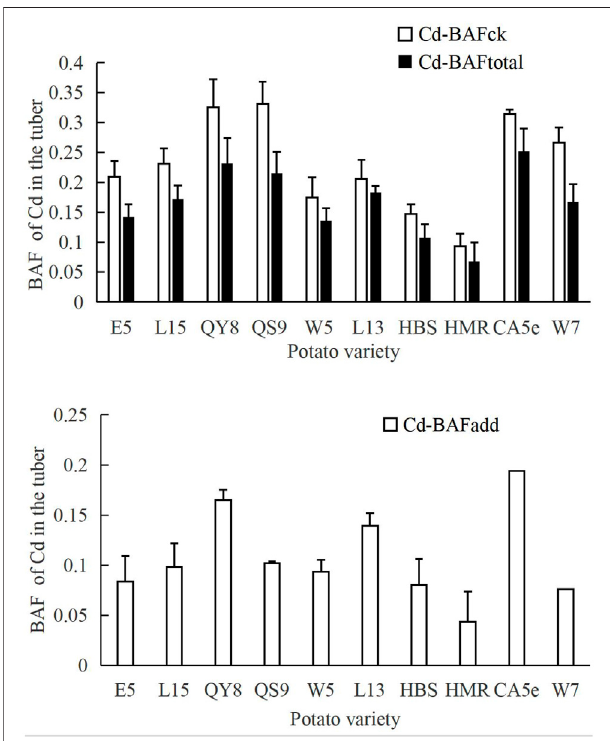
FIGURE 1 | BAF ck , BAF total and BAF add for different potato varieties in Weining soil.